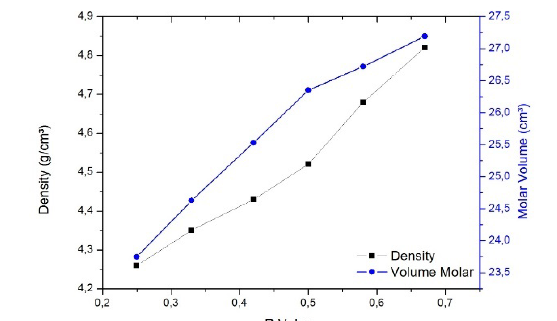
Figure 1. Density variation in R function of vitreous system and molar volume. Source: the autors (2018).